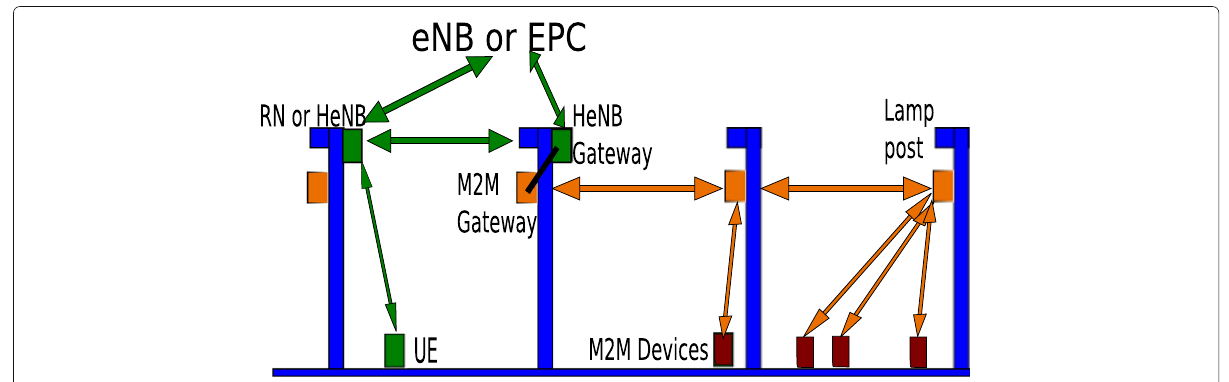
Fig. 1 High-level scenario